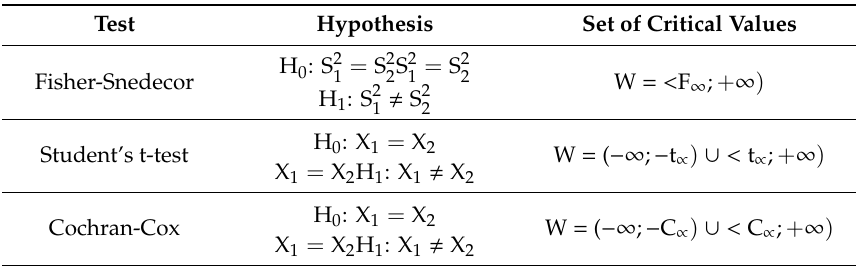
Table 4. Research hypotheses and sets of critical values for Fisher ‐ Snedecor test, Student’s t ‐ test and Cochran ‐ Cox test [27].